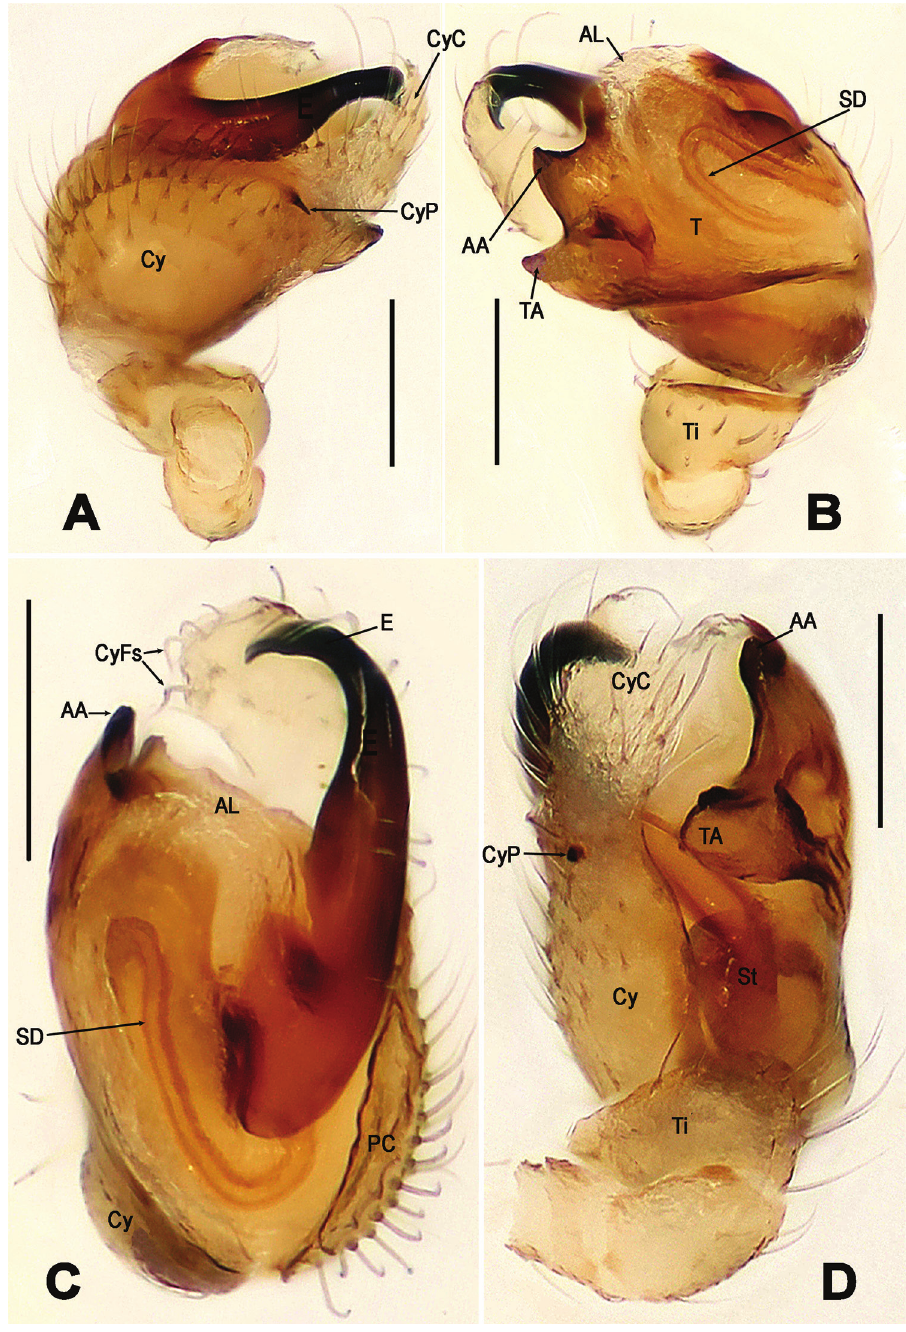
Figure 5. Trogloneta uncata Lin & Li, 2013, male left pale ( A–D ). A prolateral B retrolateral C apical D ventral. Abbreviations: AA apical apophysis; AL apical lobe; Cy cymbium; CyC cymbial conductor; CyFs setae on cymbial fold; CyP cymbial process; E embolus; TA tegular apophysis; PC paracymbium; SD spermatic duct; St subtegulum; T tegulum; Ti tibia. Scale bars: 0.10